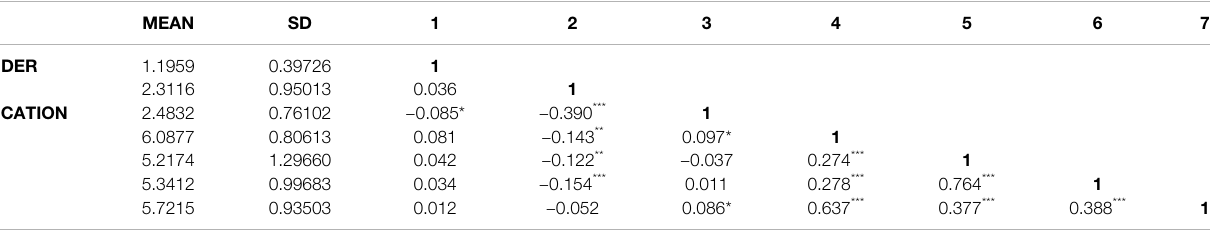
TABLE 2 | Descriptive statistics and correlation analysis.